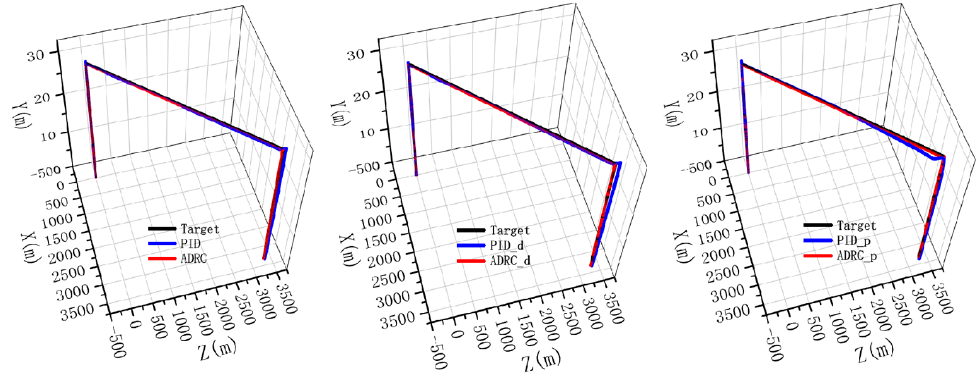
Figure 13. 3D trajectory response.